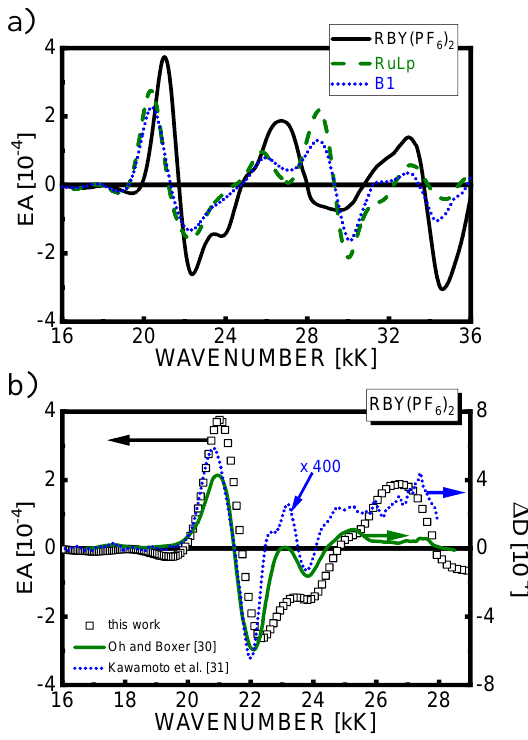
Figure 3. ( a ) Comparison of EA spectra for neat films of Ru(II) complexes: RBY(PF 6 ) 2 (solid line), RuLp(PF 6 ) 2 (dashed line), and B1(PF 6 ) 4 (dotted line); ( b ) Comparison of EA spectrum of a neat film of RBY(PF 6 ) 2 (squares) with those obtained for RBY(PF 6 ) 2 in a PVA matrix at 77 K (solid line, data taken from [30]) and RBY(Cl) 2 6H 2 O in PVA at room temperature (dotted line, data from [31]).